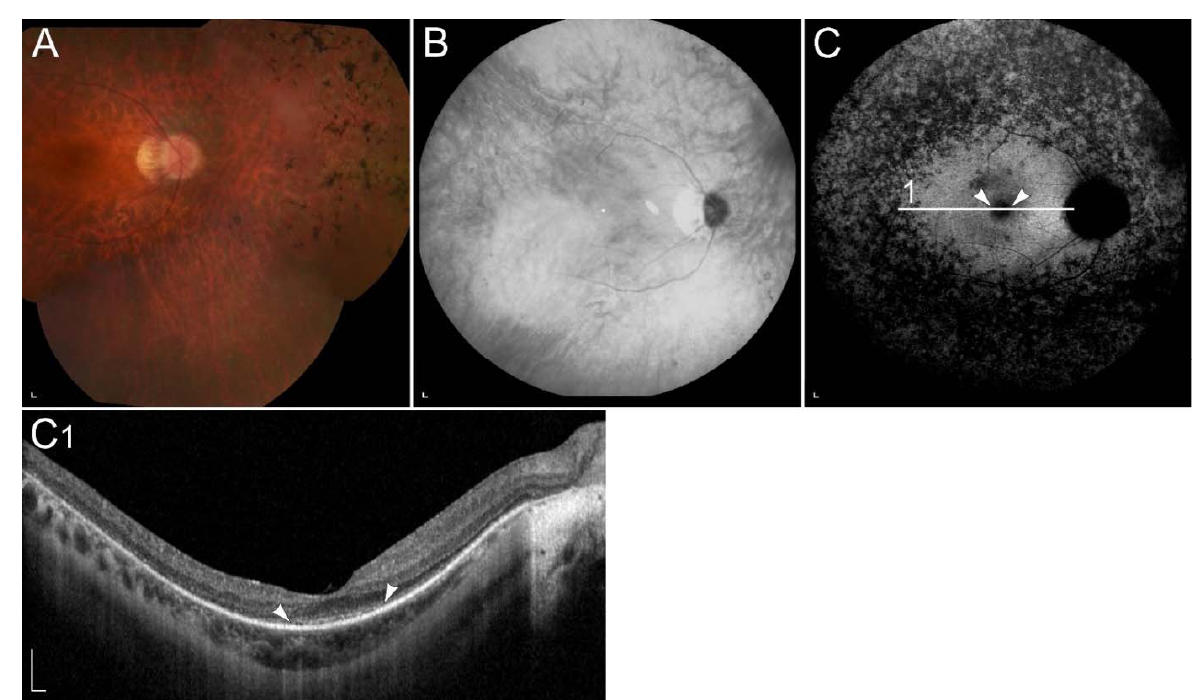
Figure 4. ( A ) Colour fundus image, ( B ) fundus infrared image and ( C ) FAF image with corresponding (C1) SD ‐ OCT image showing clinical findings in a patient with p.(Gly90Asp) in RHO . Area within the arrowheads on C and C1 images corresponds to the preserved part of the retina. Patient’s best corrected Snellen decimal visual acuity was 0.6 on the right eye and 0.4 on the left eye. Scale bars: 200 μ m. Source: Eye Hospital, University Medical Centre Ljubljana.